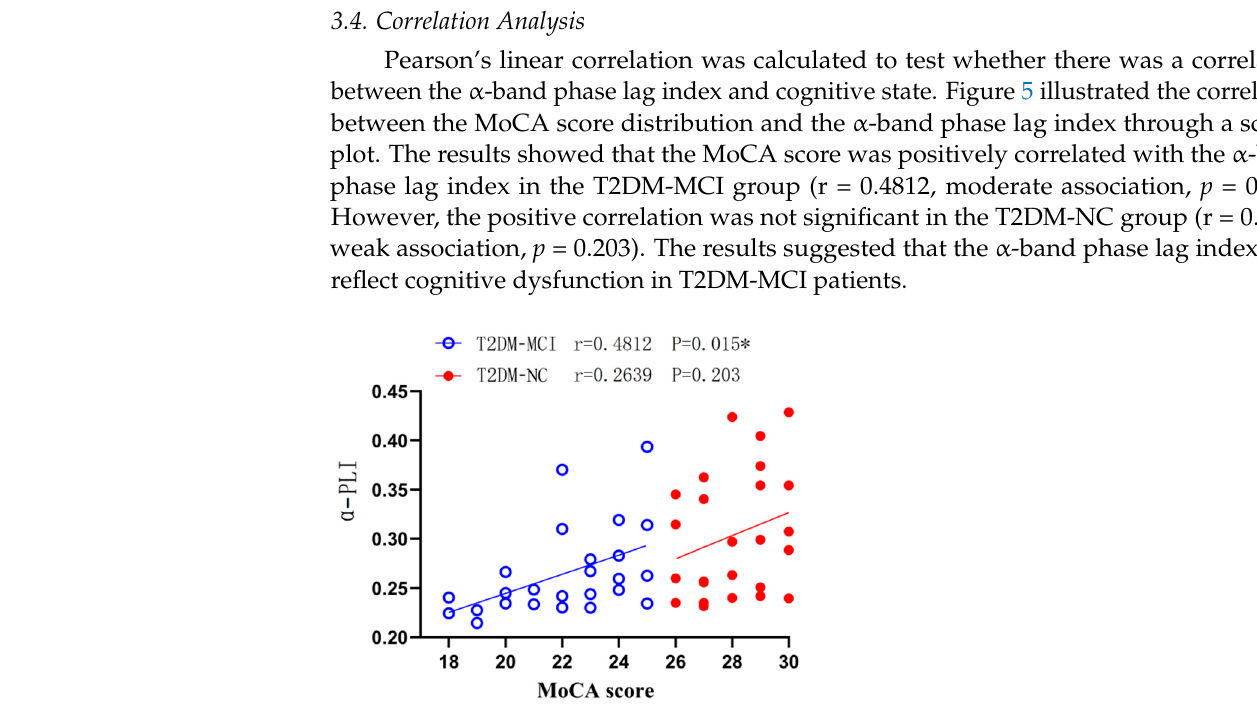
Figure 5. The linear correlation between the phase lag index and the MoCA score in the alpha